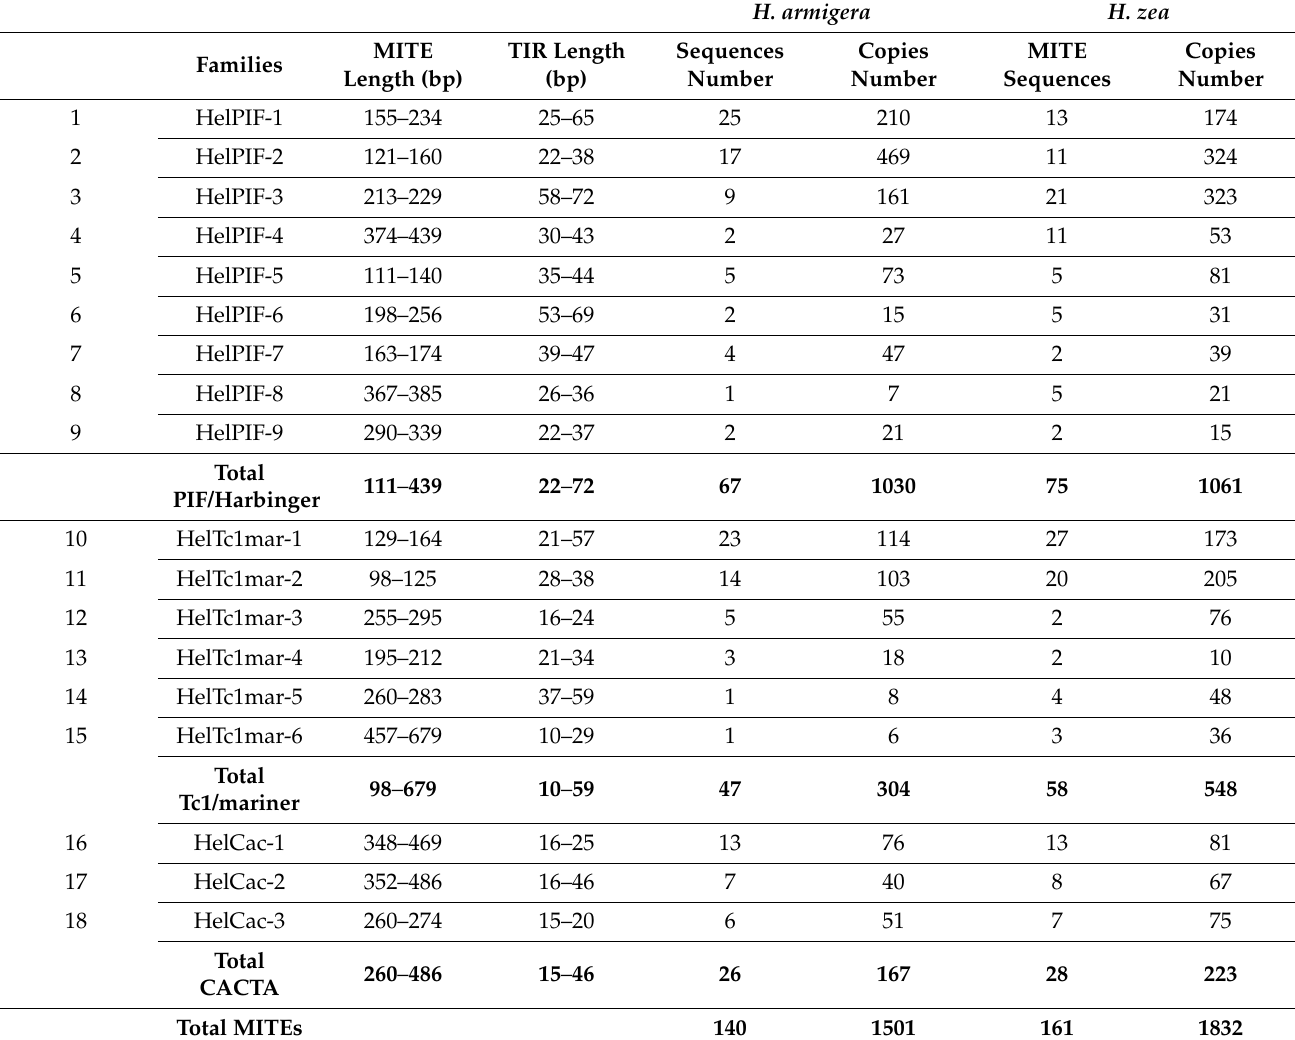
Table 2. Characteristics of the 18 MITE families in the H. armigera and H. zea genomes. H.